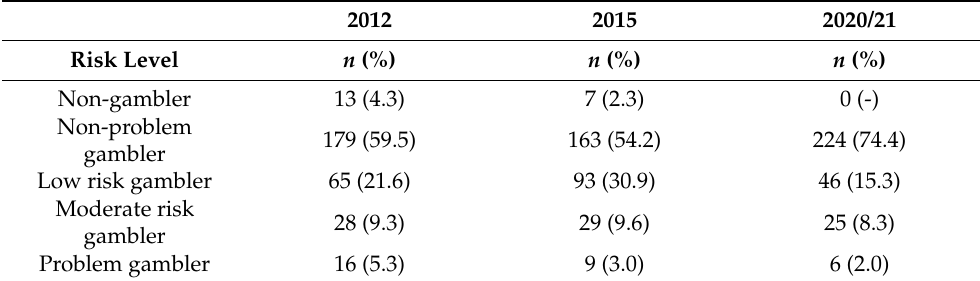
Table 3. Gambling risk level by data collection